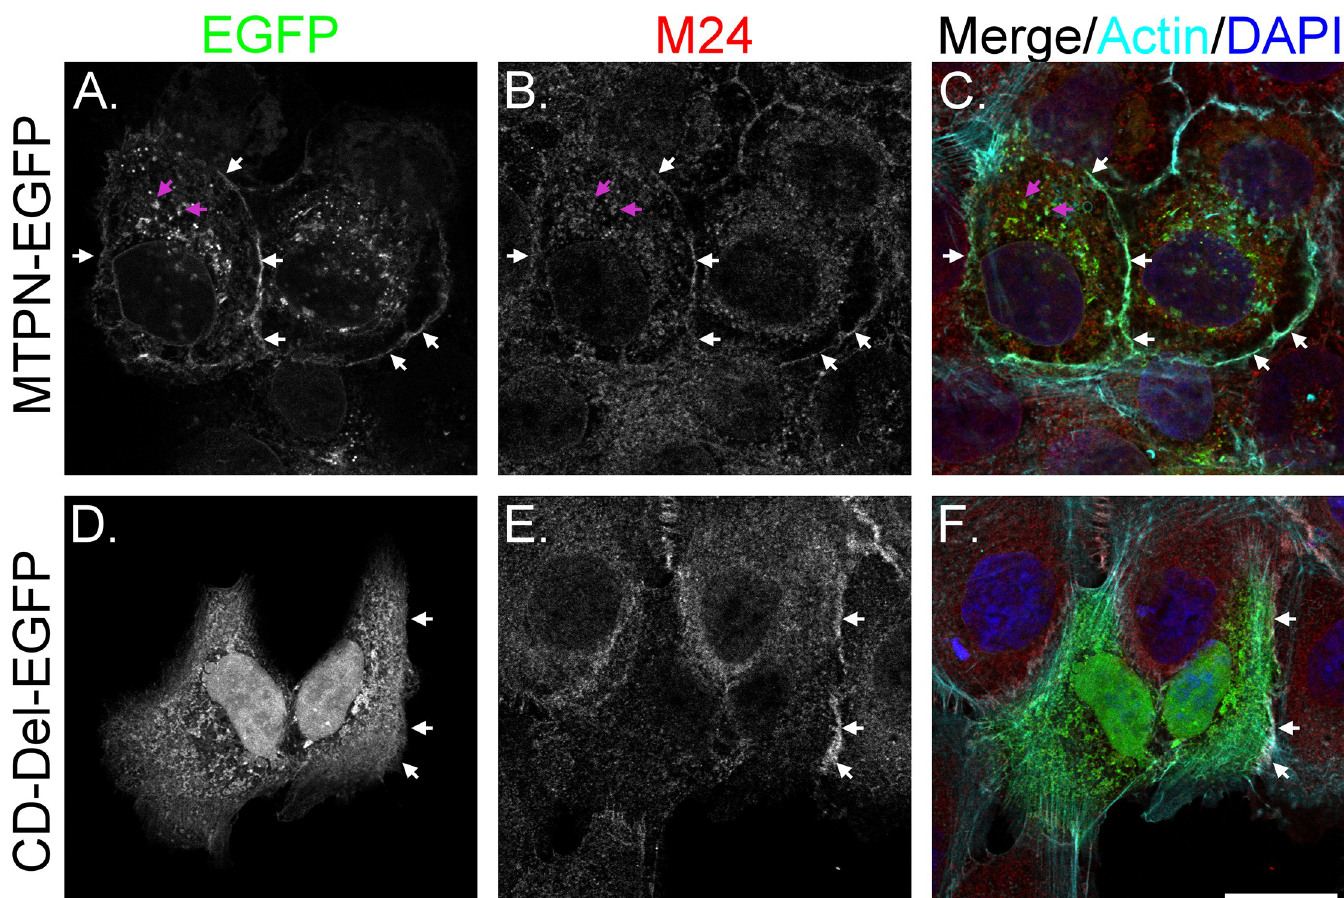
Fig 2. Matriptase cytoplasmic domain is required for targeting to the cell periphery. Both the wild-type (MTPN-EGFP) and cytoplasmic domain deleted (CD-Del- EGFP) matriptase-EGFP constructs were transiently expressed in HaCaT human keratinocytes. The subcellular localization of both MTPN-EGFP (A and C) and CD-Del-EGFP (D and F) were compared with the endogenous matriptase, which was analyzed by indirect immunofluorescent staining with the matriptase-specific mAb M24 (B and E) followed by Alexa 594-labeled anti-mouse IgG. The cells were also stained for F-actin using Alexa 660-labeled phalloidin ( C and F , Cyan) and nuclei using DAPI (C and F, blue), as counterstains. The staining is presented as black and white images (A, B, D, and E) and as merged false-color images ( C and F ). The white arrowheads indicate cell periphery and red arrowheads indicate intracellular vesicles. Scale bar: 10 μ m.